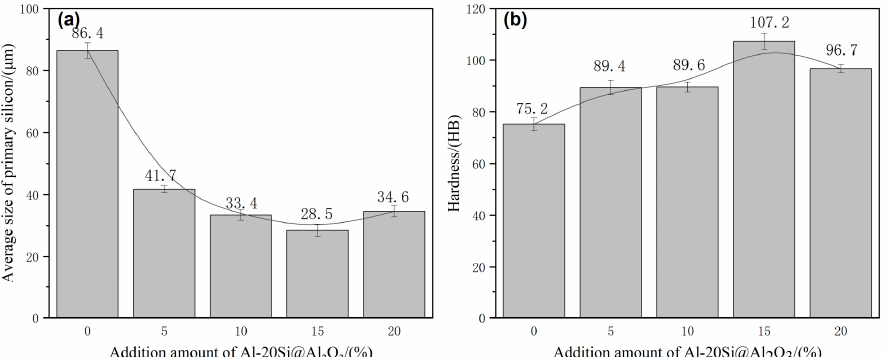
Figure 8. Average size of primary silicon and hardness of Al–20Si alloys modified with different amounts of Al-Si@Al 2 O 3 powder: ( a ) average size of primary silicon; ( b ) HB hardness.